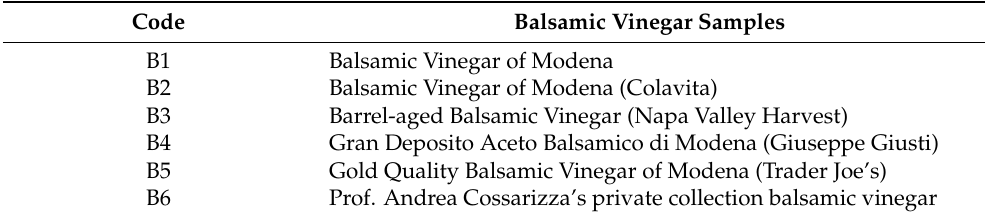
Table A1. Tested balsamic vinegar samples.